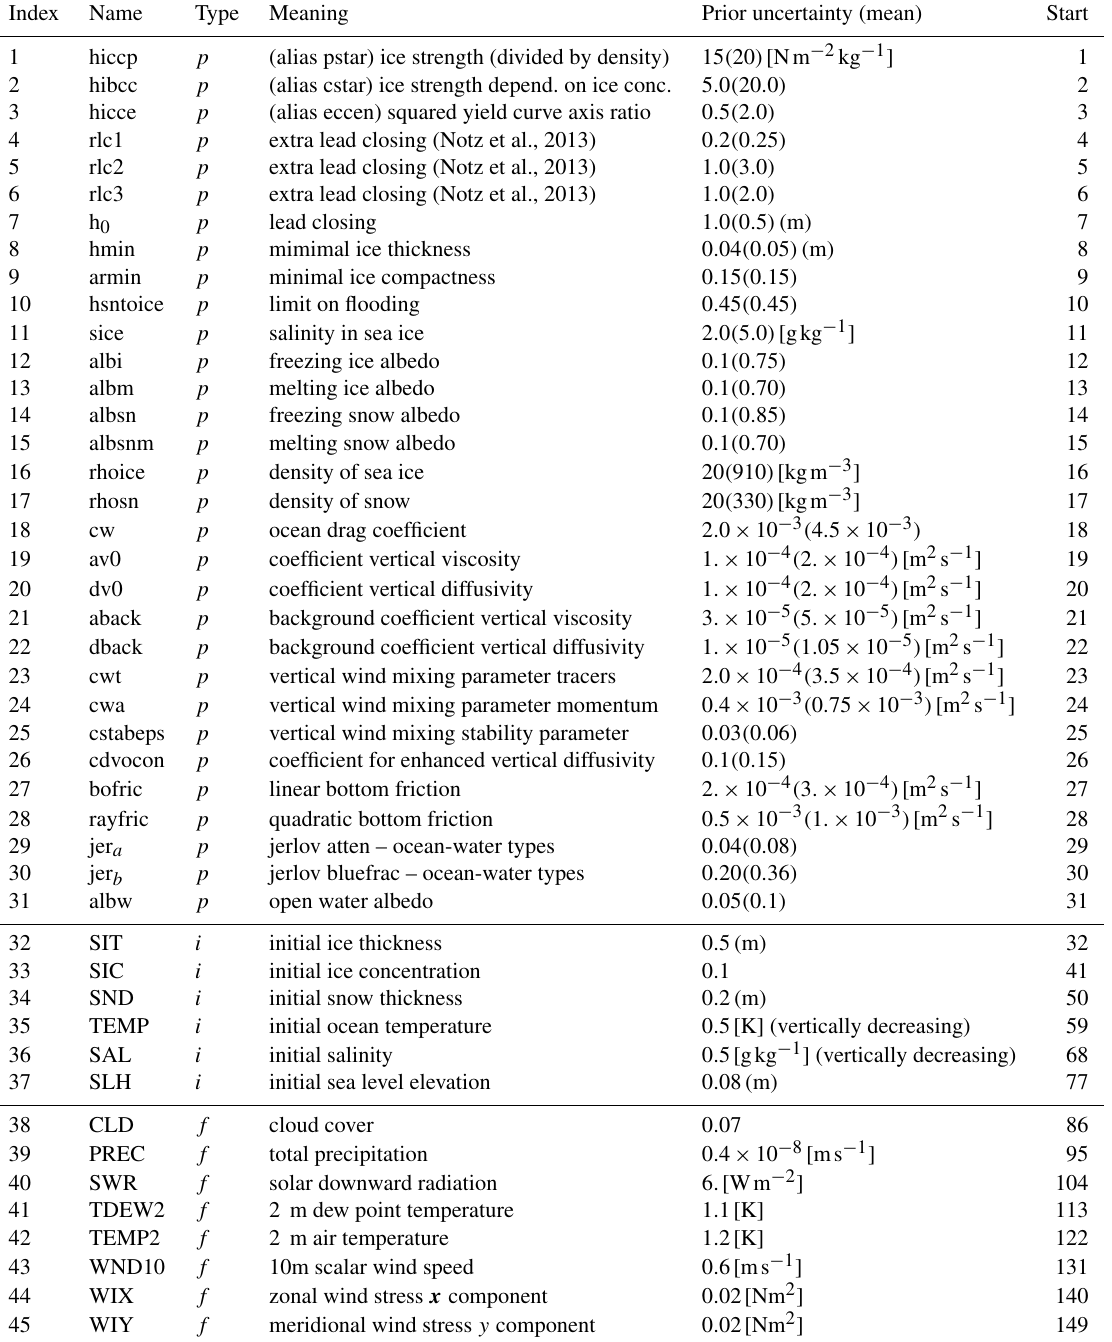
Table 1. Control variables. Column 1 lists the quantities in the control vector; column 2 gives the abbreviation for each quantity; column 3 indicates whether the quantity is a process parameter ( p ), an initial field ( i ), or an atmospheric boundary field (denoted by f for forcing); column 4 gives the name of each quantity; column 5 indicates the prior uncertainty (1 standard deviation) and the corresponding units (unless unitless) and provides the mean parameter value in parenthesis, where applicable; and column 6 identifies the position of the quantity in the control vector – for initial and boundary values (which are differentiated by region) this position refers to the first region, while the following components of the control vector then cover regions 2 to